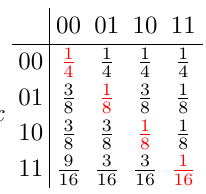
Table 2: Bit-flip from 1 to 0 with 75 % and from 0 to 1 with 50